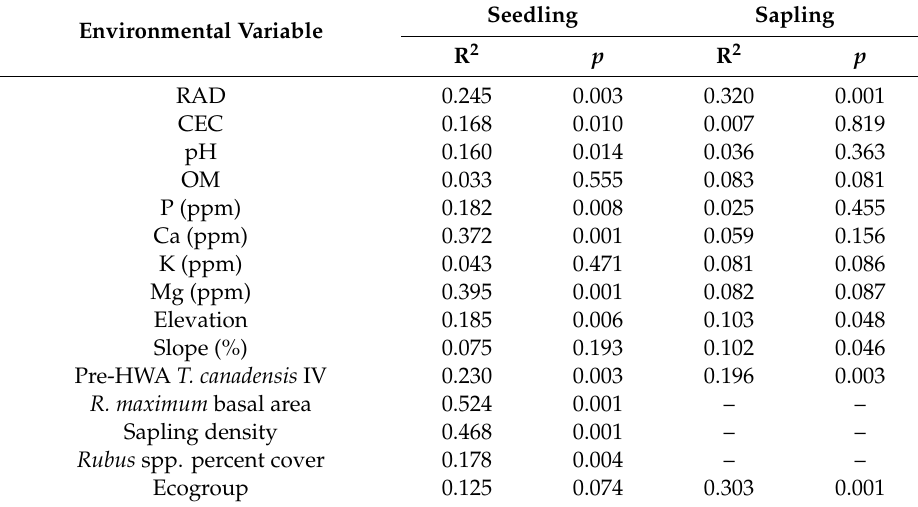
Table 3. Correlation coe ffi cients of environmental variables with NMDS ordination results for the seedling and sapling